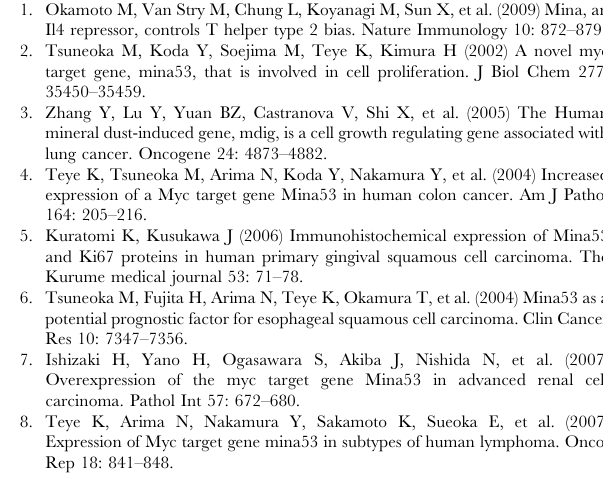
Table S1 Electromobility shift and ChIP assay primers and